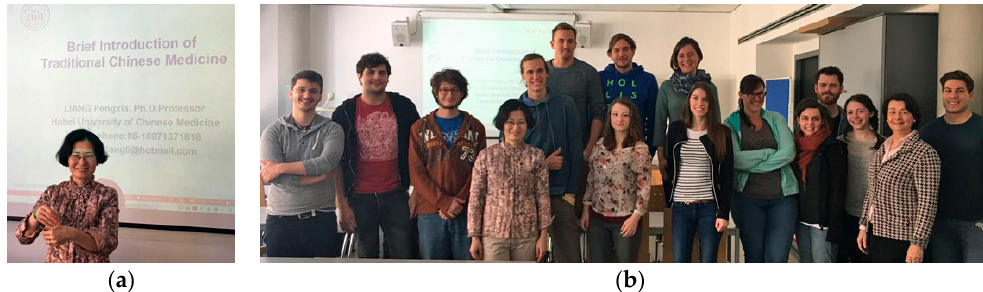
Figure 3. Professor Liang Fengxia ( a ) in Graz, Austria, 16 February 2017. Student lecture from Professor Liang at the Medical University of Graz. Coordinator: Dr. Andrea Pribyl (2nd on the right side) ( b ). 12 March 2017: Eurasia Pacific Uninet (EPU). Joint project with the Hubei University of Chinese Medicine, Wuhan, China and the Medical University of Graz, Graz, Austria.